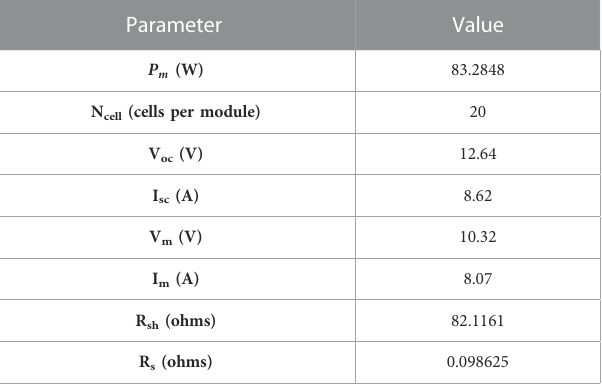
TABLE 1 Parameters of the PV model using